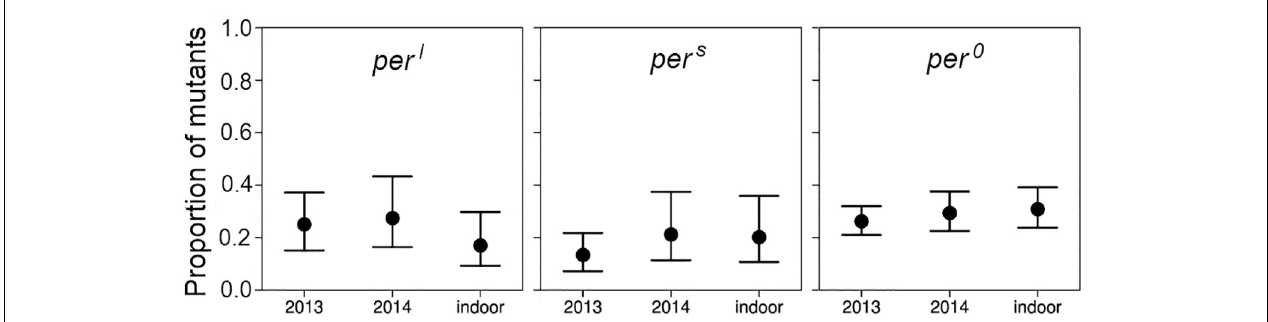
FIGURE 8 | Proportion and binomial 95% CI-intervals of mutant males after three generations of competition with wildtype flies under outdoor and indoor conditions. Data stem from the experiments carried out under external (natural) light conditions in 2013 and 2014 and from the third generation census of the long-term competition experiments under the 24-h day in the laboratory (see Figure 7